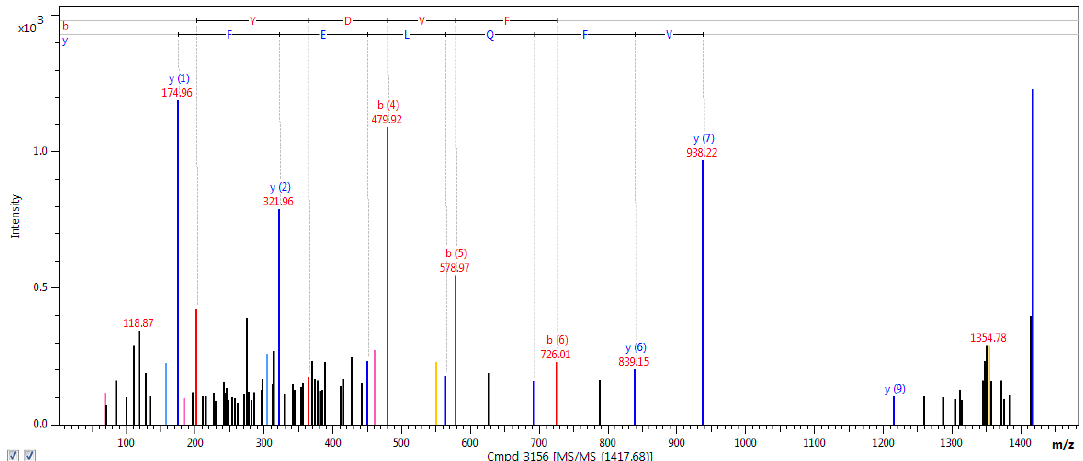
fascin Figure 3. The representative example of the mass spectrum of m / z 1417.6834, identified as one of the fascin peptides.